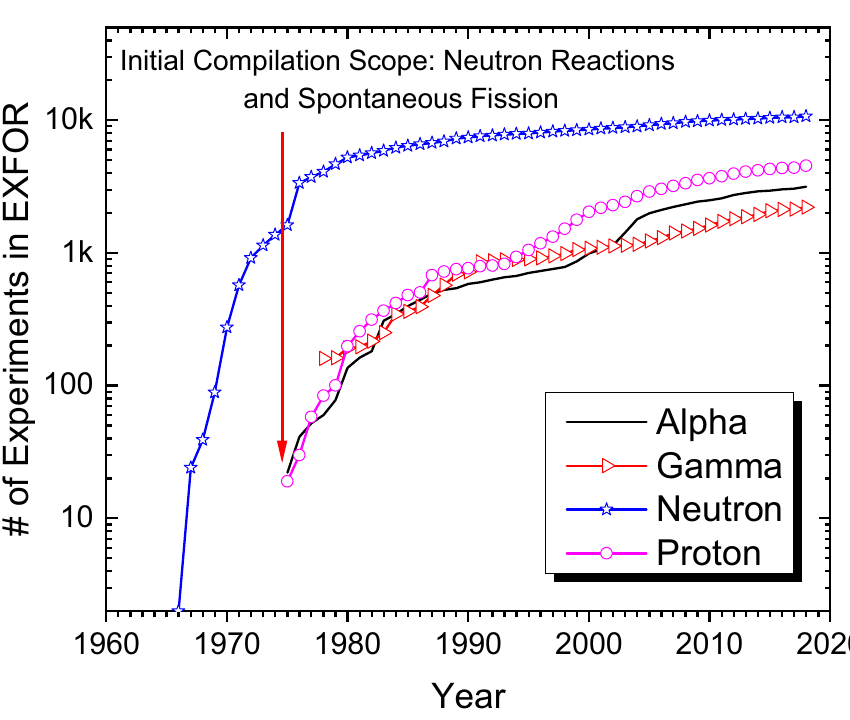
Figure 3. EXFOR compilation timeline shows evolution of the library compilation scope and data contents over the